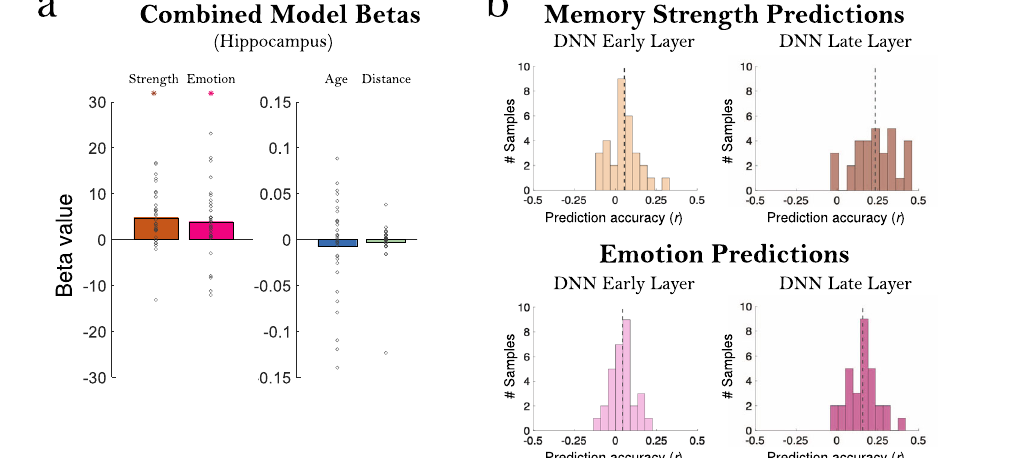
accuracy of the VGG-16 Deep Learning Neural Network (DNN) layer activations on themiddlevideoframe,forpredictingmemorystrengthandemotionratings.Each histogram shows the distribution of prediction accuracy (Pearson correlation r of predictions with true values of memory strength/emotion) of the 32 participant samples. The dashed gray line indicates the mean prediction accuracy across all participants.Formemorystrength,bothearly(layer2, p =0.004)andlate(layer20, p =2.11×10 − 6 ) layers were signi fi cantly able to predict memory strength from the middle frame of the videos alone (top). Early ( p =0.004) and late layers ( p =1.30×10 − 6 ) were also signi fi cantly able to predict emotion ratings from the middle video frame (bottom). Signi fi cance was assessed with two-sided Wilcoxon sign rank tests. Source data are provided in the Source Data fi